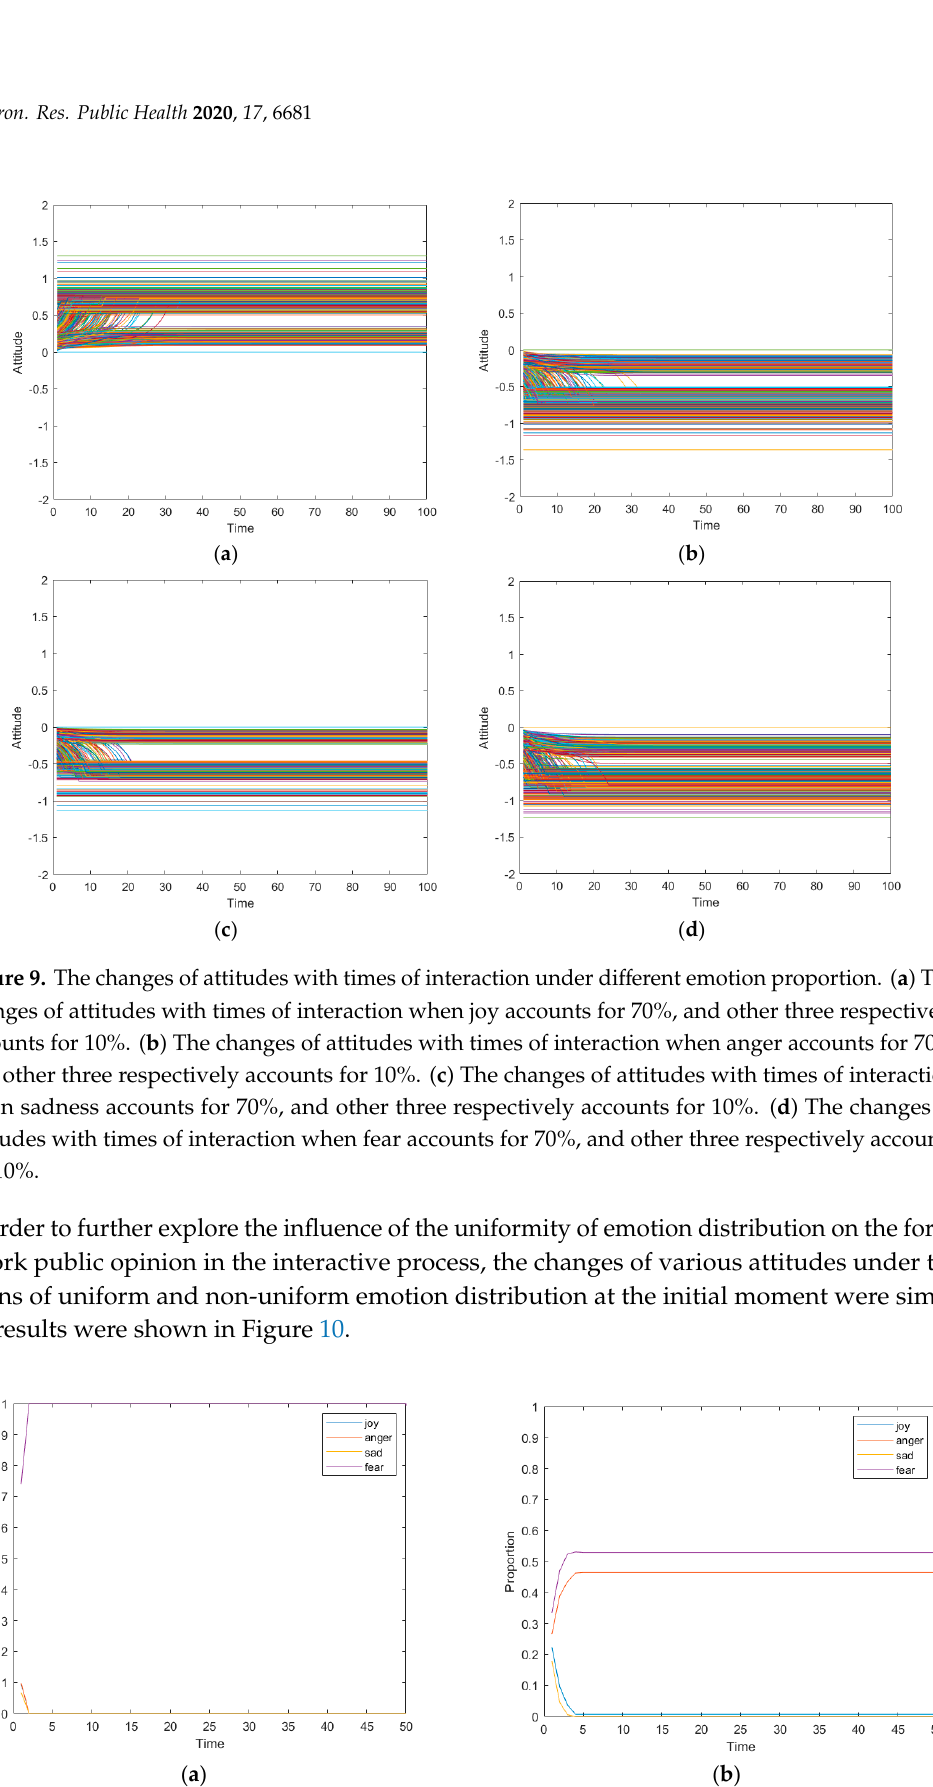
Figure 10. T he changes of various attitudes proportion with the changes of interaction times under uneven ( a ) and even ( b ) distribution of